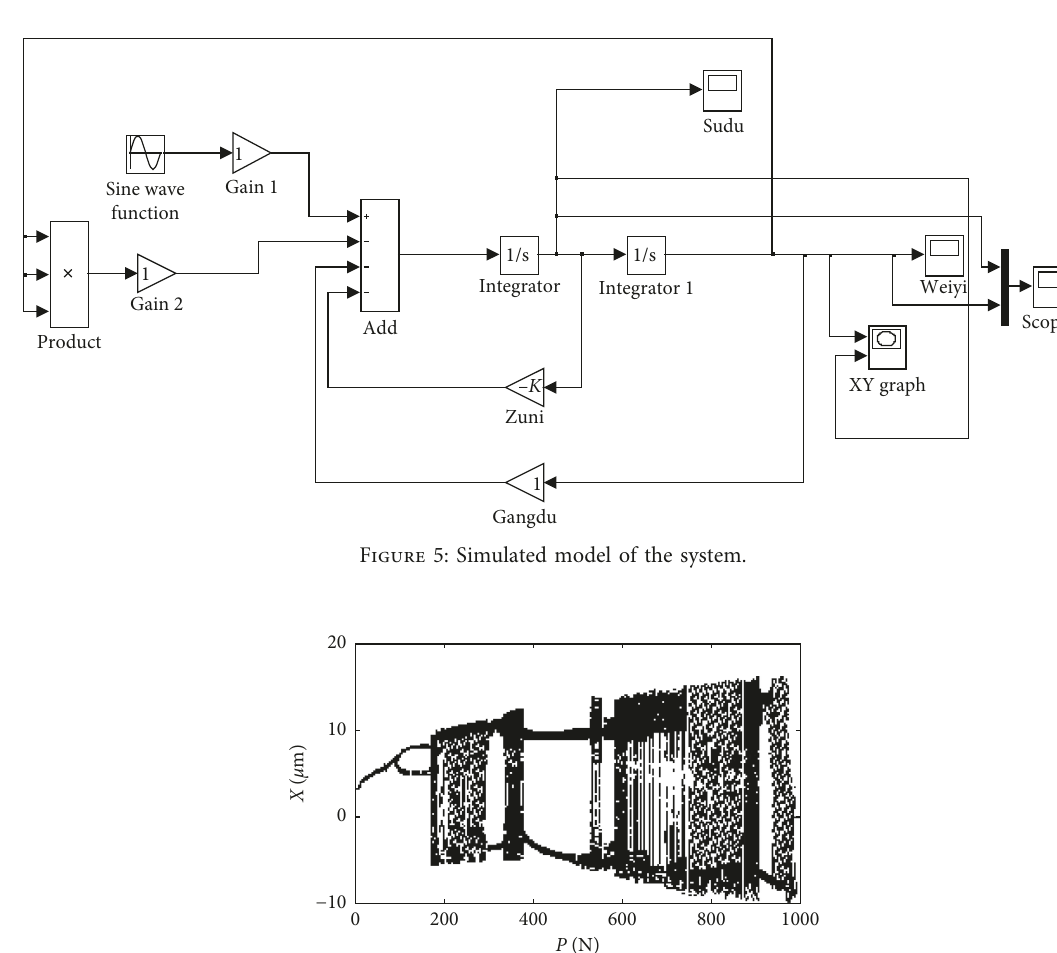
Figure 6: Bifurcation diagram with P as